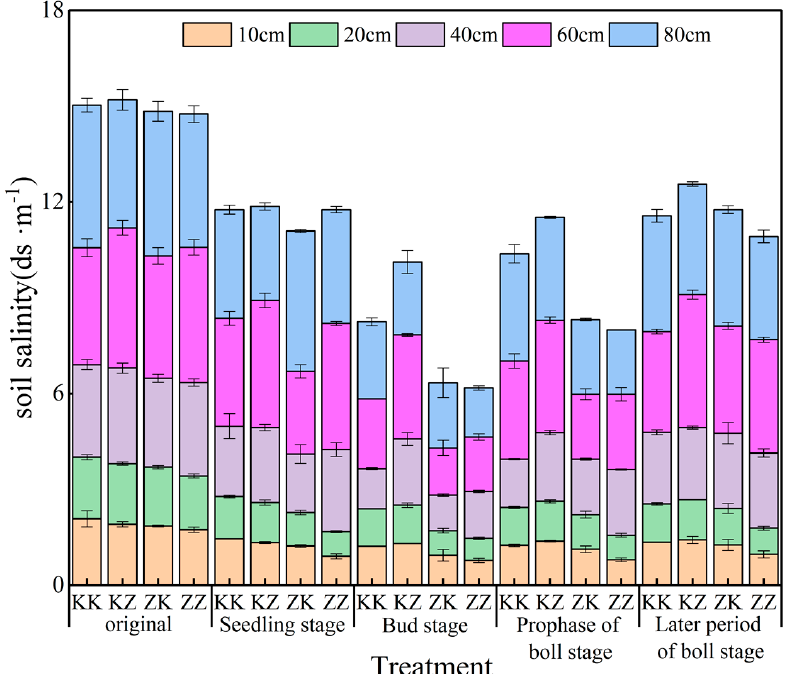
Figure 5. Dynamic changes in soil salinity in different drip irrigation treatment conditions in 2018a.